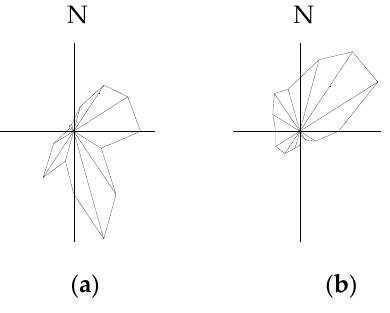
Figure 2. Wind rose diagrams of Nanjing: ( a ) Summer; ( b ) Winter. Table 1. Meteorological data for simulations.